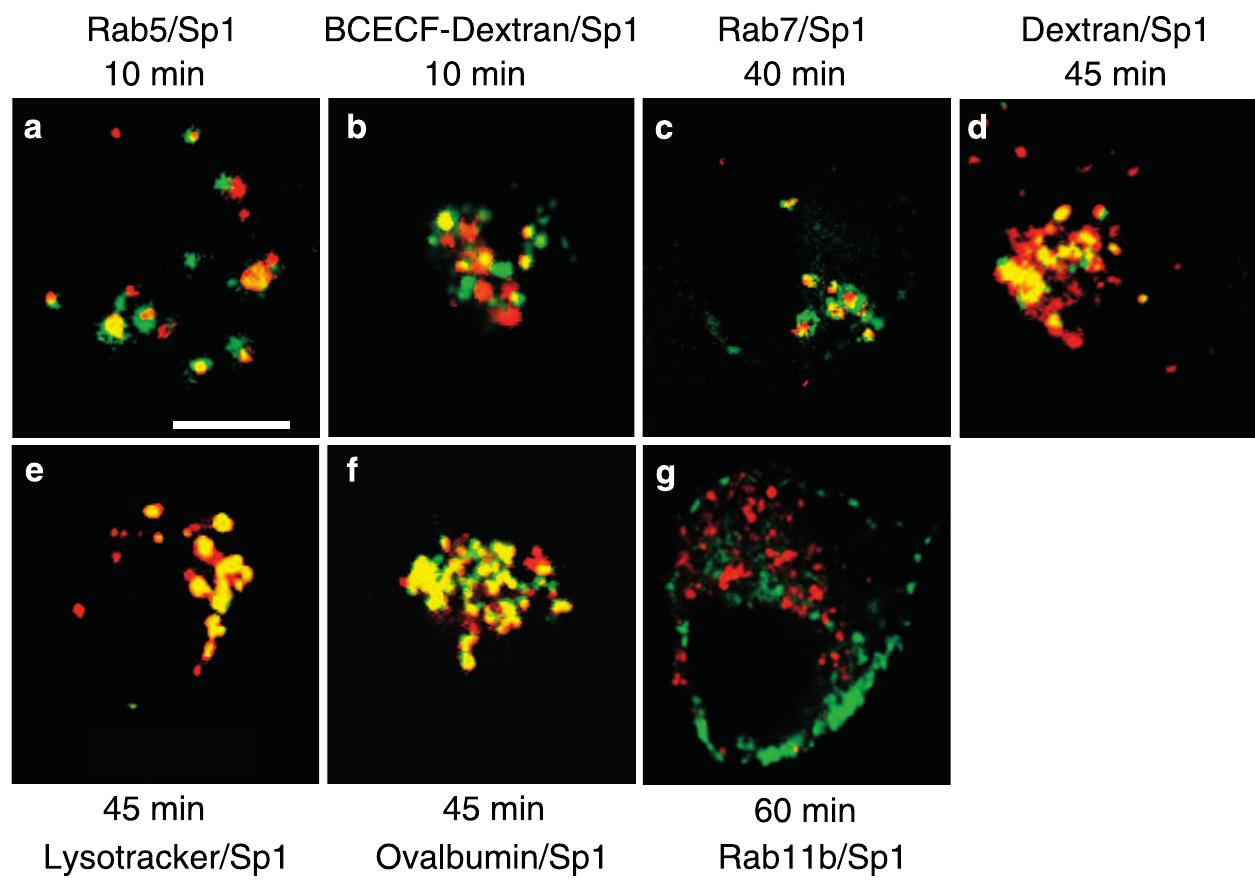
Figure 2. Intracellular Trafficking to Lysosomes of Sp1 in WT DCs (A) Merged fluorescence images of iDCs transfected with Rab5, a marker for early endosomes, and treated with Sp1-Alexa 594 (500 l g/ml) for 10 min. (B) Merged fluorescence images of iDCs incubated with BCECF-dextran (1 mg/ml), an indicator for early endosomal compartments with a pH of 6 to 7, for 45 min. iDCs were then incubated with Sp1-Alexa 594 (500 l g/ml) for 10 min. (C) Merged fluorescence images of iDCs transfected with Rab7, a marker for late endosomes, and incubated for 30 min after treatment with Sp1-Alexa 594 (500 l g/ml) for 10 min. (D) Merged fluorescence images of iDCs treated simultaneously for 45 min with Sp1-Alexa 594 (500 l g/ml) and dextran-Alexa Fluor 488 (1.5 mg/ml), a marker for late endosomes/lysosomes. (E) Merged fluorescence images of iDCs treated simultaneously for 45 min with Sp1-Alexa 488 (500 l g/ml) and LysoTracker Red DND-99 (50 nM), a marker for lysosomes with a pH of 3 to 5. (F) Merged fluorescence images of iDCs treated simultaneously for 45 min with Sp1-Alexa 594 (500 l g/ml) and ovalbumin-FITC (1 mg/ml). (G) Merged fluorescence images of iDCs transfected with Rab11b, a marker for recycling endosomes, and incubated for 1 h after treatment with Sp1- Alexa 594 (500 l g/ml) for 60 min.